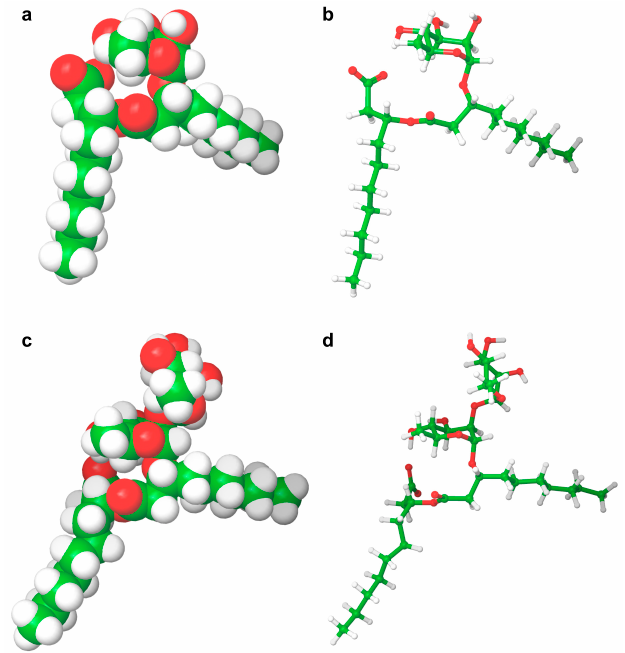
Figure 2. Molecular structures of the most abundant and frequently found rhamnolipids: the mono- rhamnolipid l-rhamnosyl-3-hydroxydecanoyl-3-hydroxydecanoate (Rha-C 10 -C 10 , R1) in ( a ) sphere (CPK) and ( b ) ball & stick representations, respectively, and the di-rhamnolipid α -l-rhamnopyranosyl- α -l-rhamnopyranosyl- β -hydroxydecanoyl- β -hydroxydecanoate di-rhamnolipid (Rha-Rha-C 10 -C 10 , R2) in ( c ) sphere (CPK) and ( d ) ball & stick representations, respectively. The molecules are coloured according to the Atom Type of MacroModel (green: carbon atoms; white: hydrogens; red: oxygen atoms). The structures were built using the Built facility in Maestro program in the Schrödinger suite (Maestro, Schrödinger, LLC, New York, NY, USA) and, then, minimized using AMBER* force field and water as solvent [181].